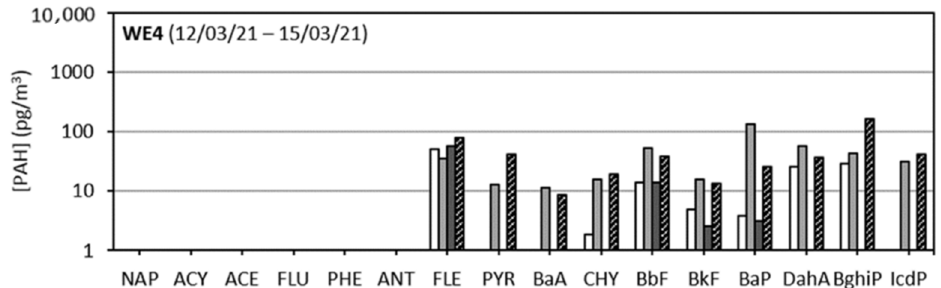
Figure 8. Individual PAH concentration distribution in collection plates (D ae > 10 µ m, 10 µ m > D ae > 2.5 µ m, and 2.5 µ m > D ae > 1 µ m) for every period of sampling. (* used to indicate the sampling periods when the pollution episodes occurred.)